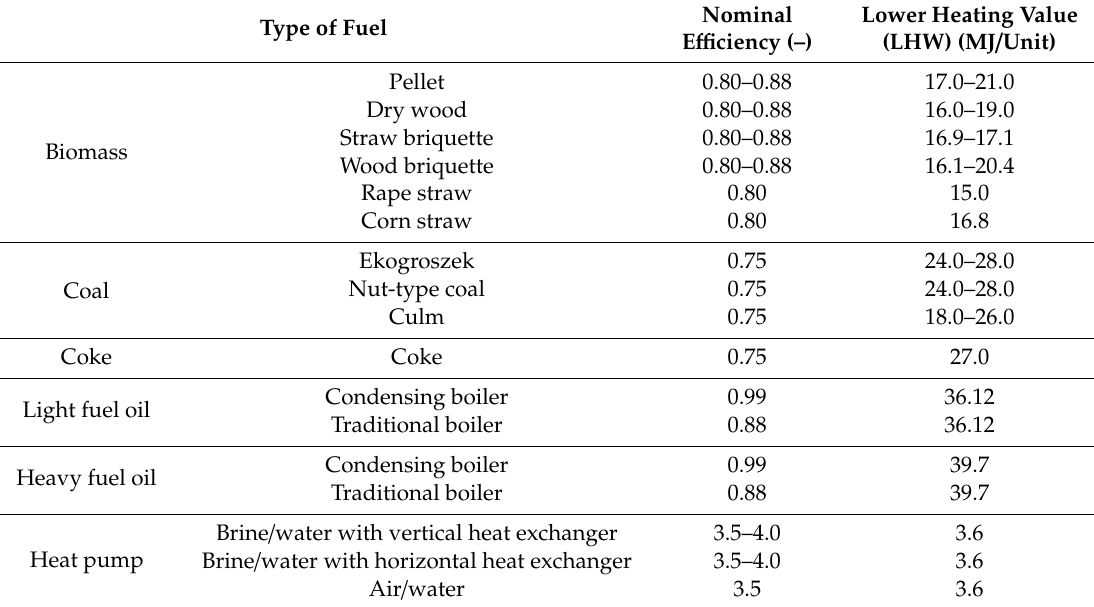
Table 1. Type of fuels, nominal e ffi ciency and lower heating value (LHW) used in calculations